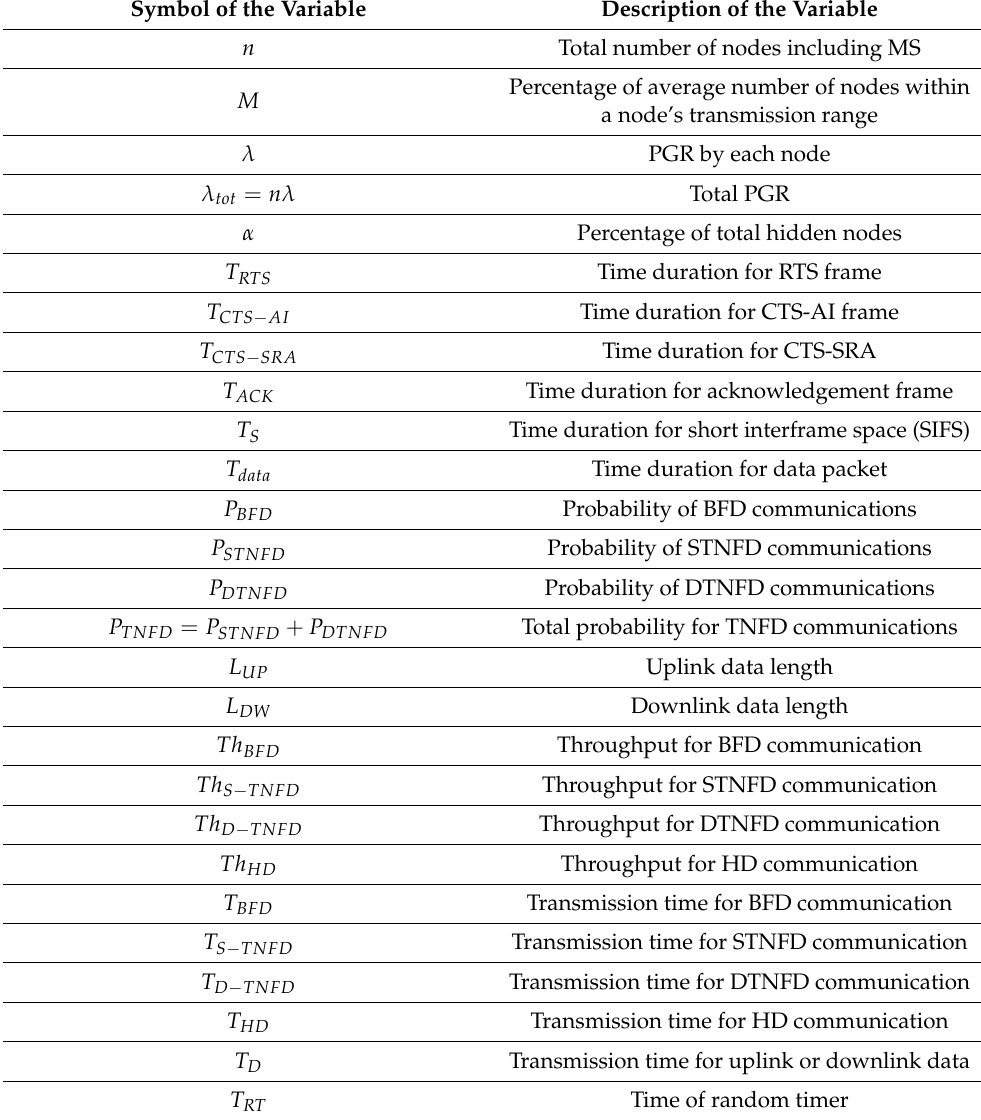
Table 1. Declaration of